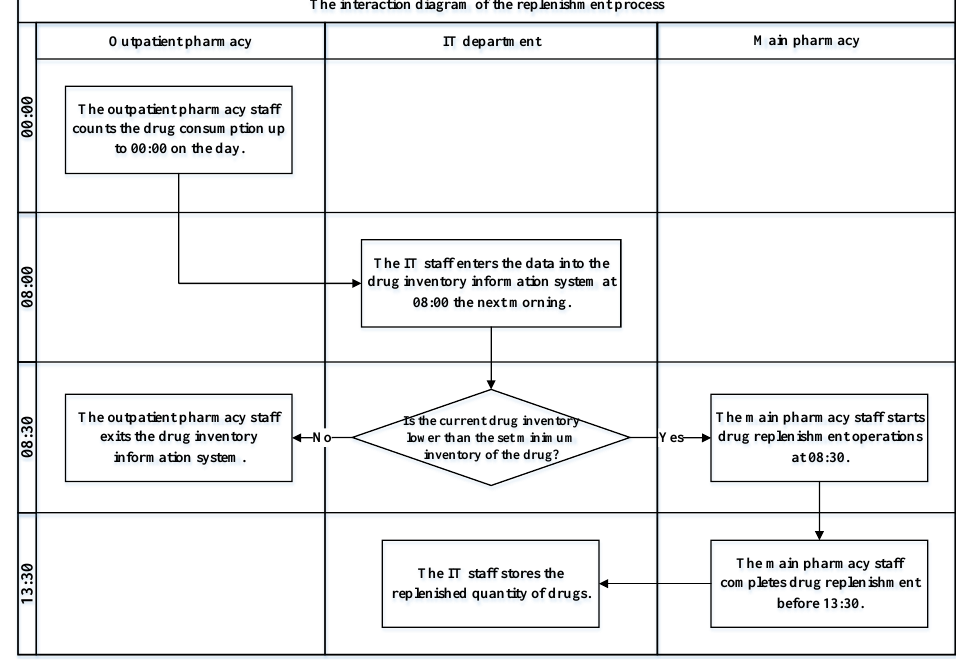
Figure 2. The replenishment process of the outpatient pharmacy of the case hospital. Regarding the main pharmacy ordering process of the case hospital, first, the main pharmacy staff determine the replenishment quantity of each subpharmacy through the drug inventory information system to determine whether the inventory of a certain drug in the main pharmacy is lower than the set minimum inventory of the drug. If the drug inventory is higher than the set minimum inventory of the drug, an order is not made; conversely, if the drug’s inventory in the main pharmacy is lower than the set minimum drug inventory, the drug inventory information system generates a reminder that the drug needs to be ordered. Then, the main pharmacy staff determine the ordering quantity of the drug and place an order to the drug supplier, as shown in Figure 3. The replenishment process of the main pharmacy of the case hospital is that the sup- plier delivers the ordered drug to the inventory area of the main pharmacy within the specified time. Then, the main pharmacy staff check the drug, including whether the cor- rectness and quantity of the drug are in line with the order. The main pharmacy staff subpackage the drugs that pass the inspection into the minimum packaging quantity, as established in the hospital, and label them for ease of management. After these operations are completed, the drugs are stored in the main pharmacy, as shown in Figure 4.